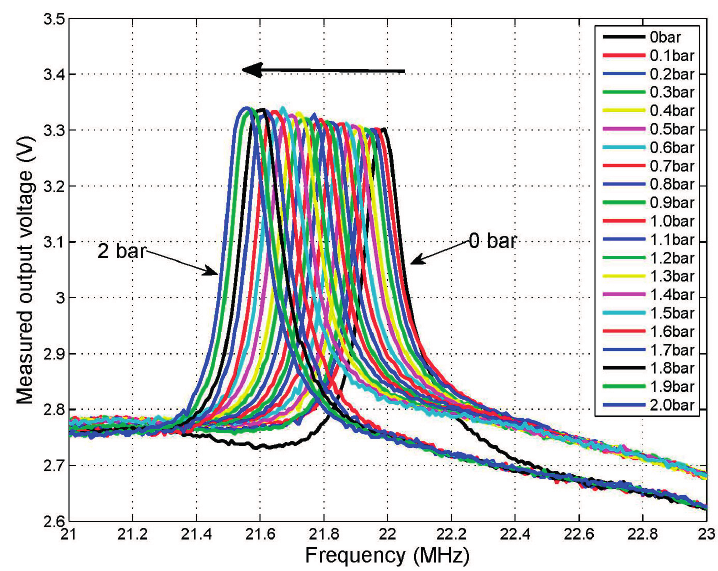
Figure 10. The measured output voltage versus frequency from 0 bar to 2 bar.